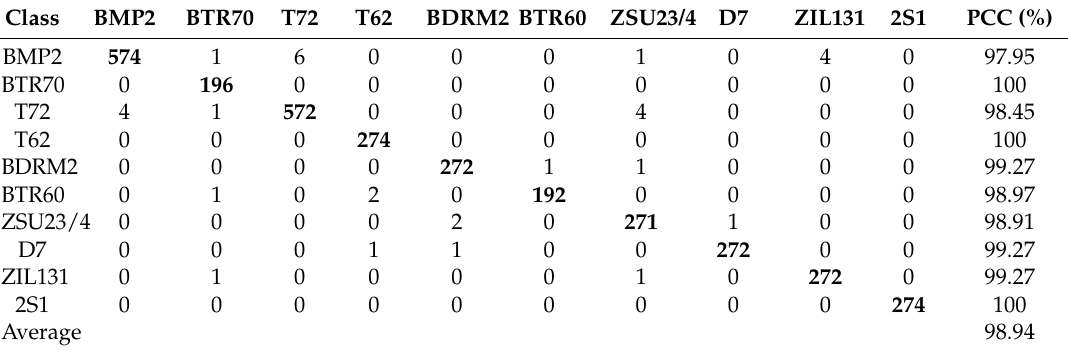
Table 3. Confusion matrix of the proposed method under standard operating conditions